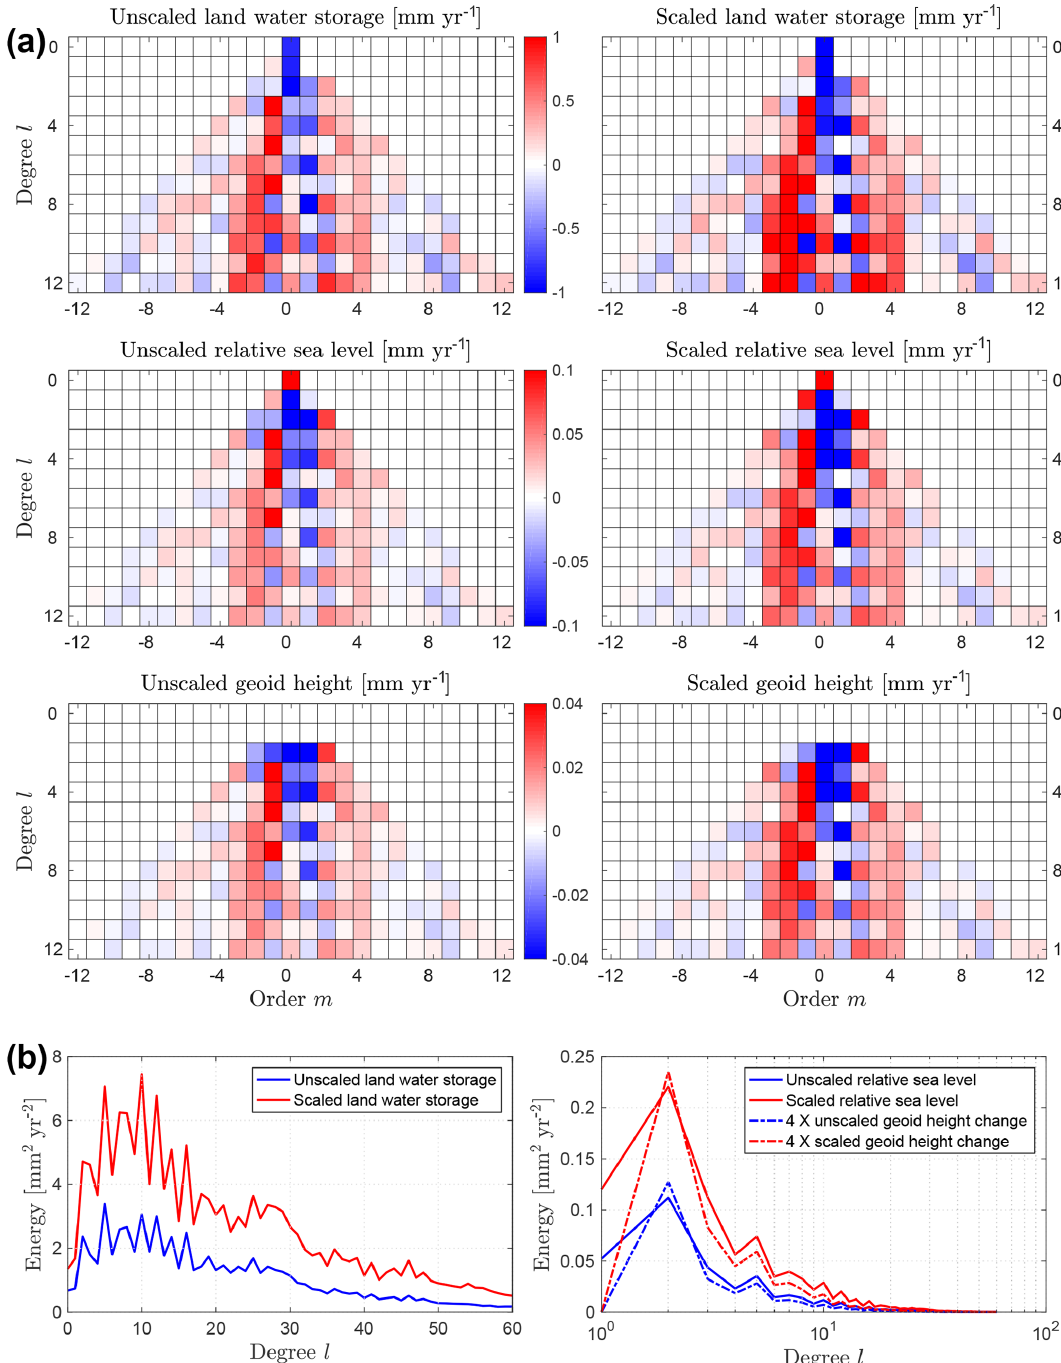
Figure 2. Effects of scaling on the select spherical harmonic coefficients. (a) Scaling effects on the average rate of change in land water storage, relative sea level and geoid height, during April 2002 through March 2016. These solutions are based on JPL Stokes coefficients and are computed in the CM reference frame with the rotational feedback included. (b) Distribution of energy, computed for a given degree l as a sum of the squares of corresponding orders m , for unscaled and scaled solutions. Note the log scale on the x axis of the right panel. Unlike the geoid height change, the relative sea-level change has nonzero energy at l = 0 with magnitudes of 1 . 16 and 2 . 37mm 2 yr − 2 for unscaled and scaled solutions, respectively. Also note that solutions for geoid height change employ a different scale (factor of 4) for appropriate